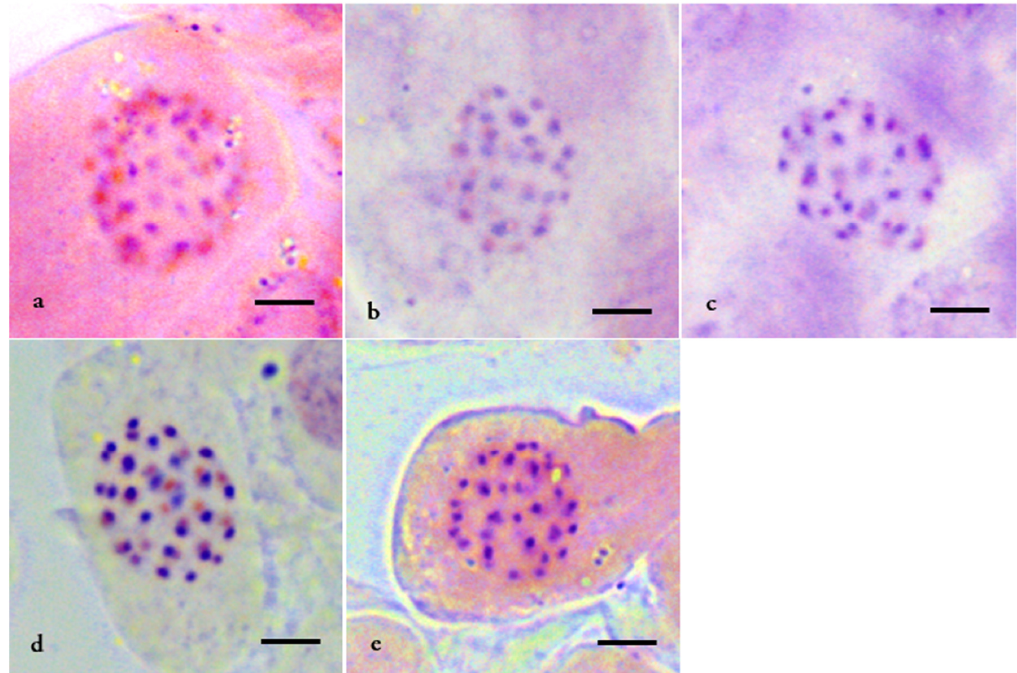
Figure 4. Effect of single and combination stain(s) on chromosomes of N. cadamba . (a) aceto-orcein